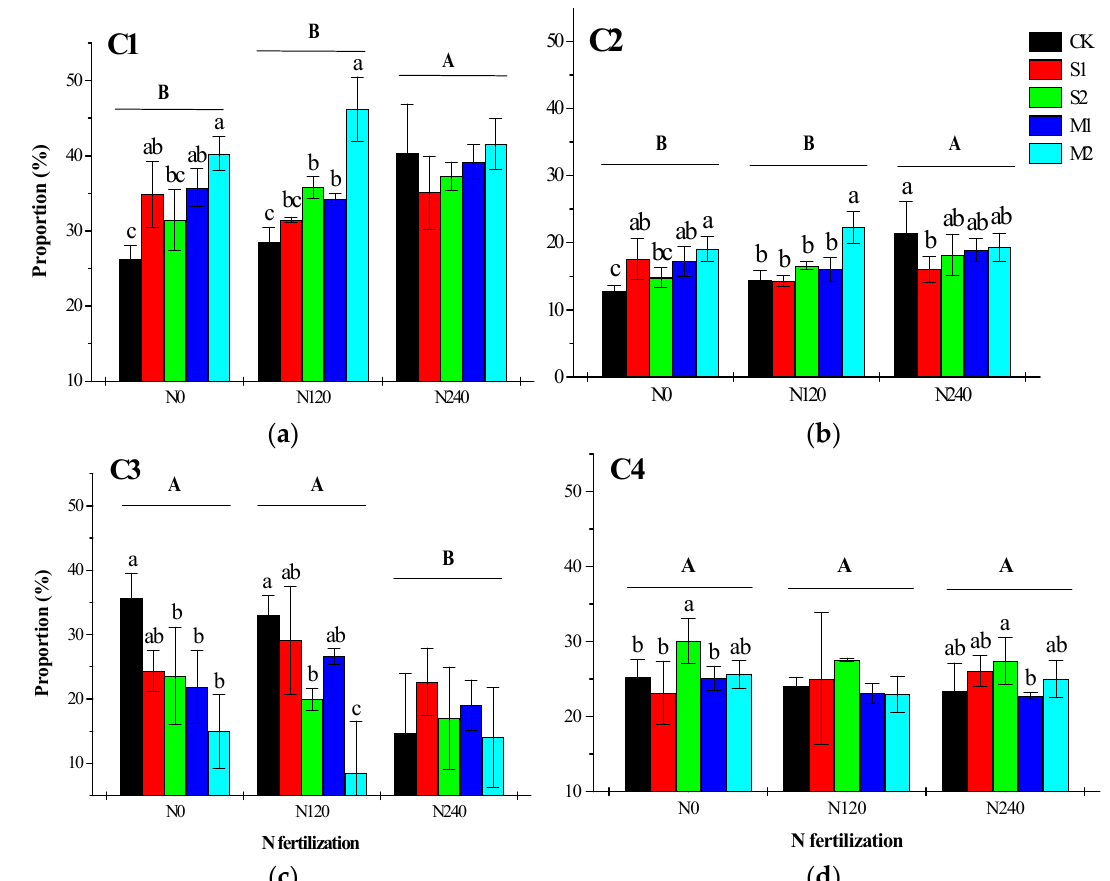
Figure 3. Excitation–emission matrix spectra and spectral loadings of the four components of water- extractable organic matter identified by parallel factor analysis: ( a ) excitation–emission matrix spec- tra of Component 1; ( b ) spectral loadings of Component 1; ( c ) excitation–emission matrix spectra of Component 2; ( d ) spectral loadings of Component 2; ( e ) excitation–emission matrix spectra of Com- ponent 3; ( f ) spectral loadings of Component 3; ( g ) excitation–emission matrix spectra of Compo- nent 4; ( h ) spectral loadings of Component 4.